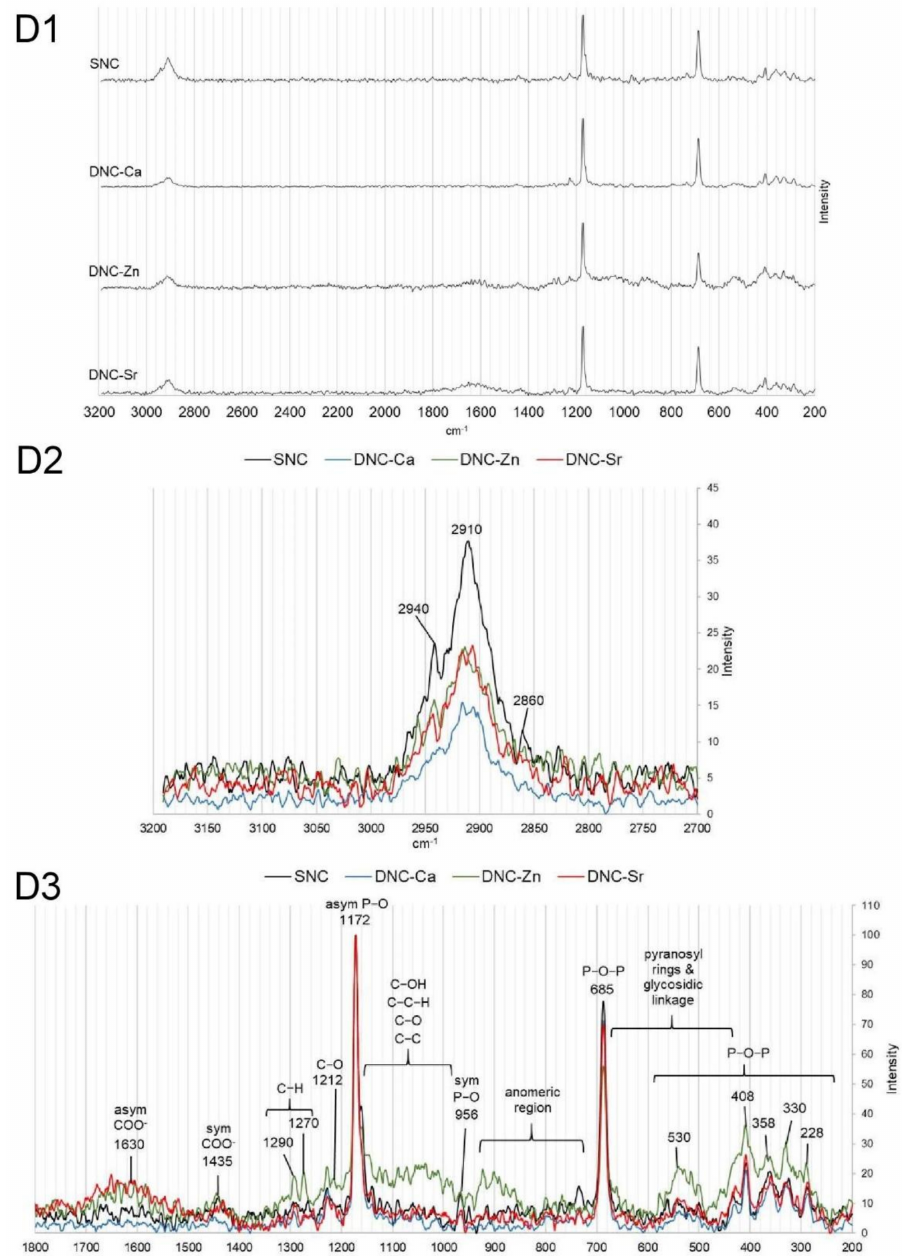
Figure 1. Dual network composites chelated with Ca 2+ (DNC-Ca), Zn 2+ (DNC-Zn) and Sr 2+ (DNC- Sr): ( A ) X-ray diffraction (XRD) patterns, identical to those of β -CMP; ( B ) 13 C-nuclear magnetic resonance (NMR) spectra; ( C1 ) attenuated total reflectance Fourier transform infrared spectroscopy (ATR-FTIR) with full spectral range, ( C2 ) stacked and expanded fingerprint region; ( D1 ) Raman spectra with full spectral range, ( D2 ) stacked, expanded peak and ( D3 ) fingerprint region compared with the single network composite